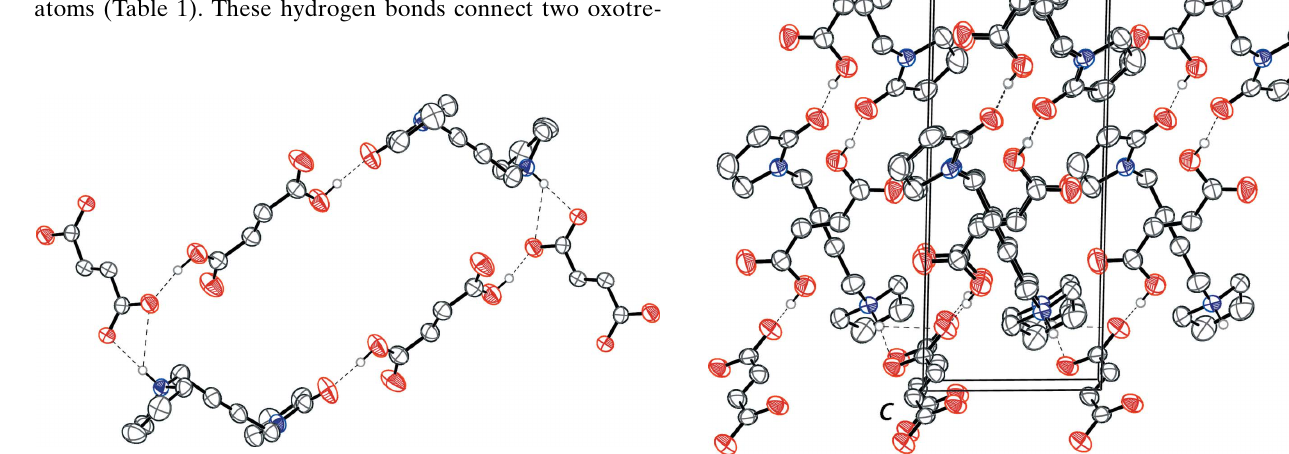
Figure 3 The crystal packing of the title compound viewed along the b axis. Hydrogen bonds are shown as dashed lines. Hydrogen atoms not involved in hydrogen bonds, and the second component of the disordered fumarate dianion are omitted for clarity.